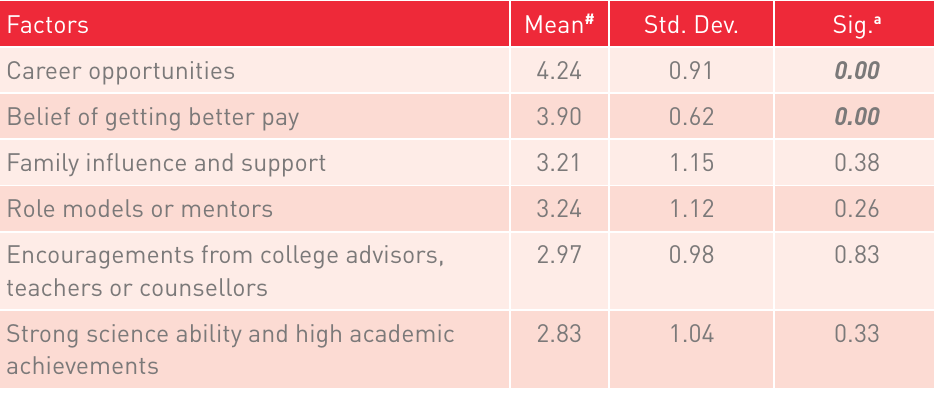
Factors influencing the respondents’ career